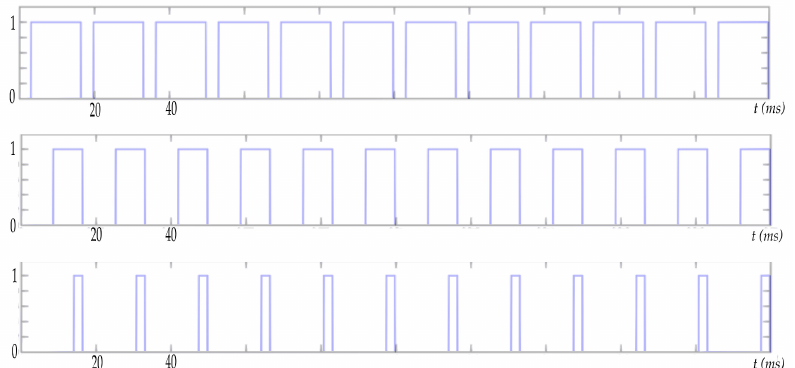
Figure 8. The membership functions from the “two closest” control areas for 50-to-50 Hz conversion and 5 ◦ , 15 ◦ , and 25 ◦ shifts according to Figure 7.